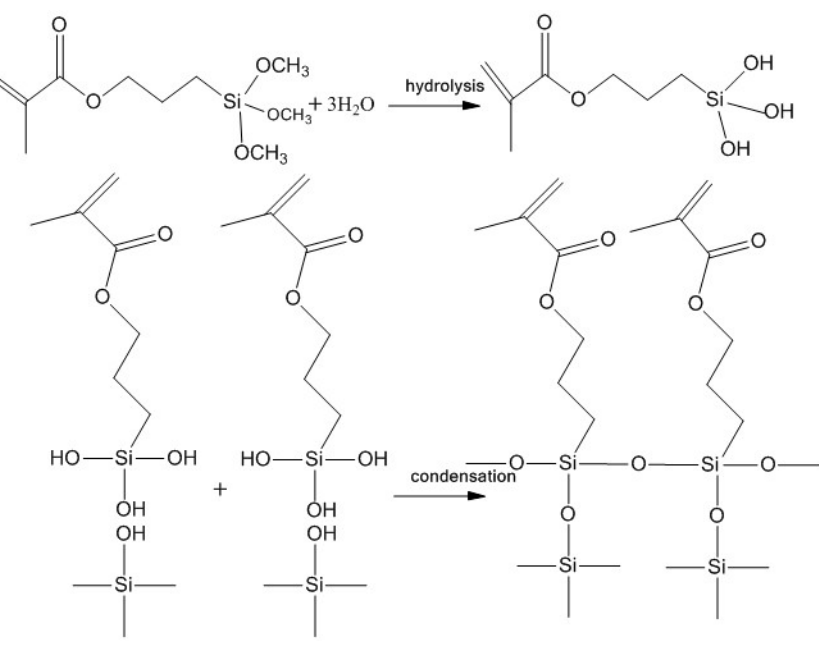
Figure 1. Hydrophobic modification mechanism of KH-570.